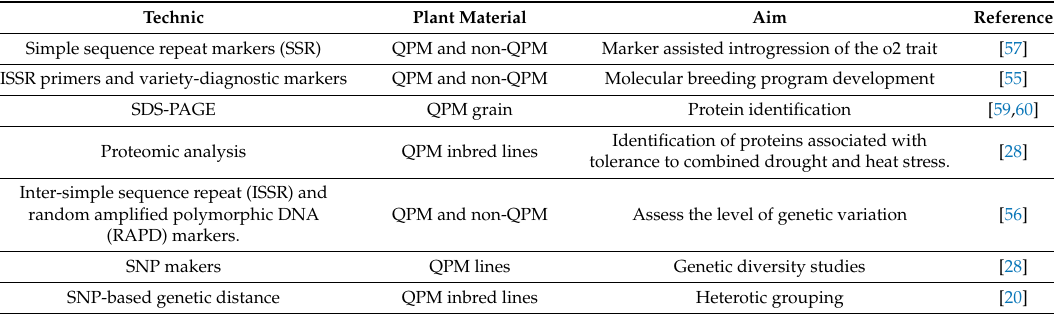
Table 5. Different molecular methods used for QPM breeding investigations. Technic Aim